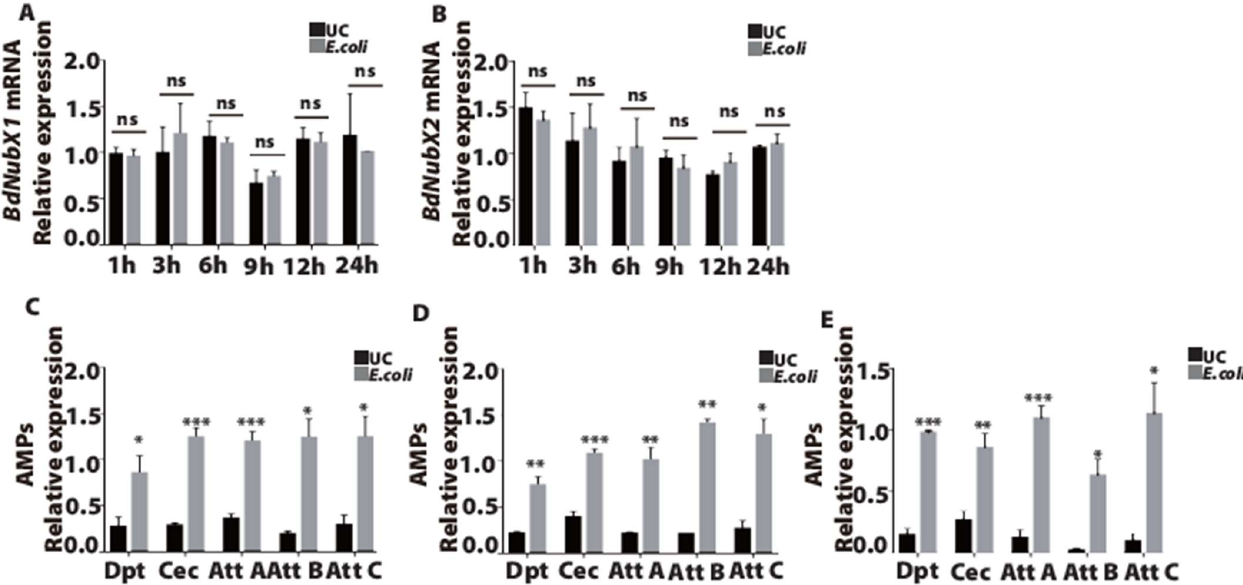
Figure 3. The immune response of BdNub after E. coli systemic infection. ( A ) The relative expression level of BdNubX1 after E. coli systemic infection. ( B ) The relative expression level of BdNubX2 after E. coli systemic infection. ( C – E ) The relative expression of AMPs genes at 3 h, 6 h, 12 h after E. coli systemic infection, respectively, ( A – E ) 30 flies samples per biological replicate, three biological replicates. Gene expressions were normalized to the reference gene RP49. UC: unchallenged flies. * p < 0.05, ** p < 0.01, *** p < 0.001, Student’s t -test.